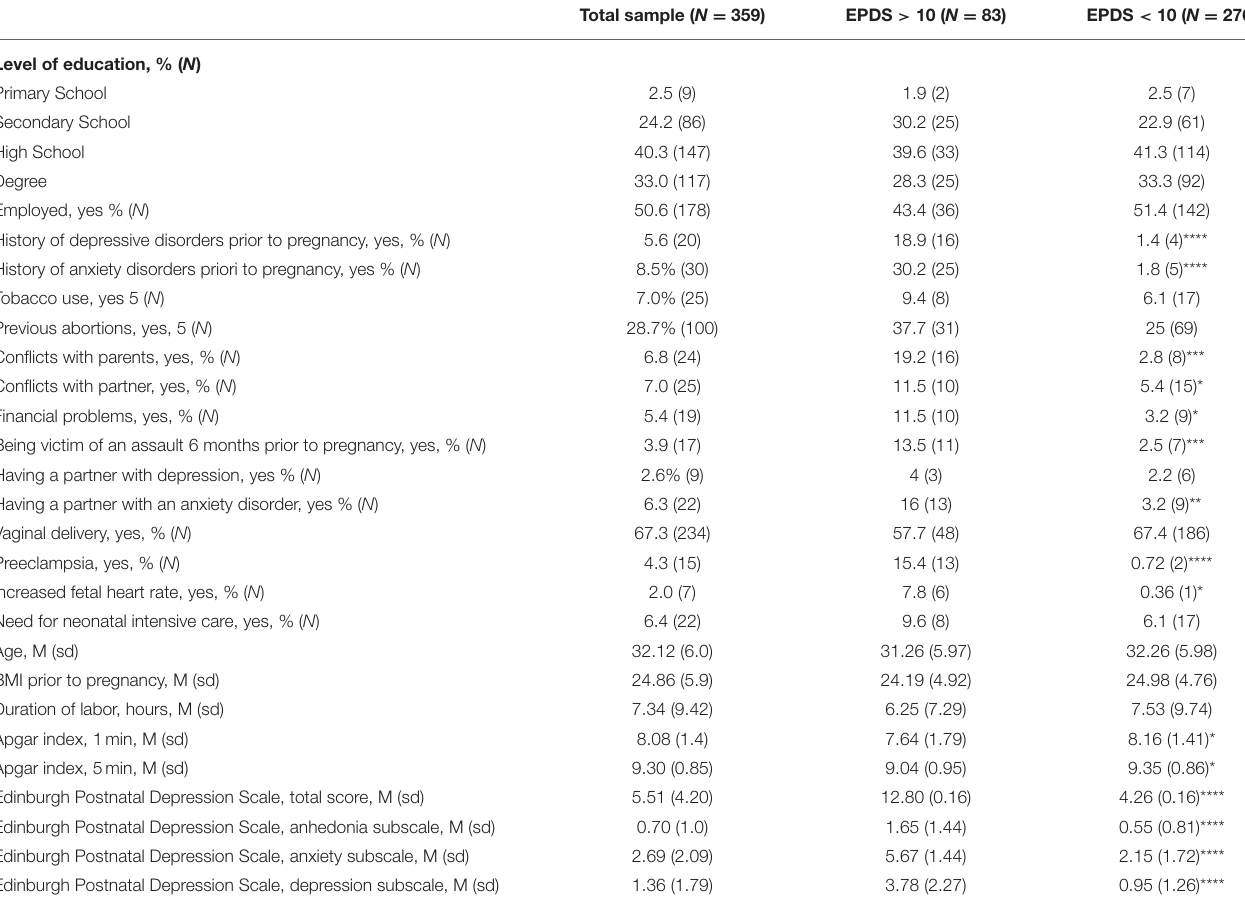
TABLE 1 | Socio-demographic and clinical characteristics of the